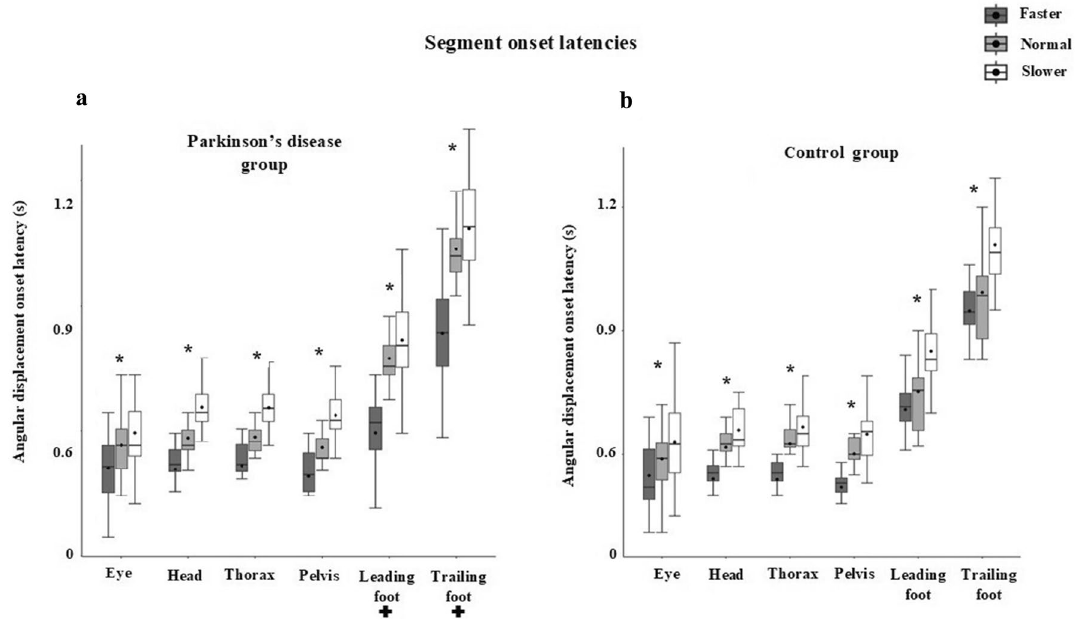
Figure 2. Boxplot demonstrating the mean angular displacement onset latencies of all segments with turning speed. Each segment onset latency was calculated with respect to the audio signal that cued the participant to initiate turning. (* shows significant main effect of turn speed and + shows significant interaction from the MM